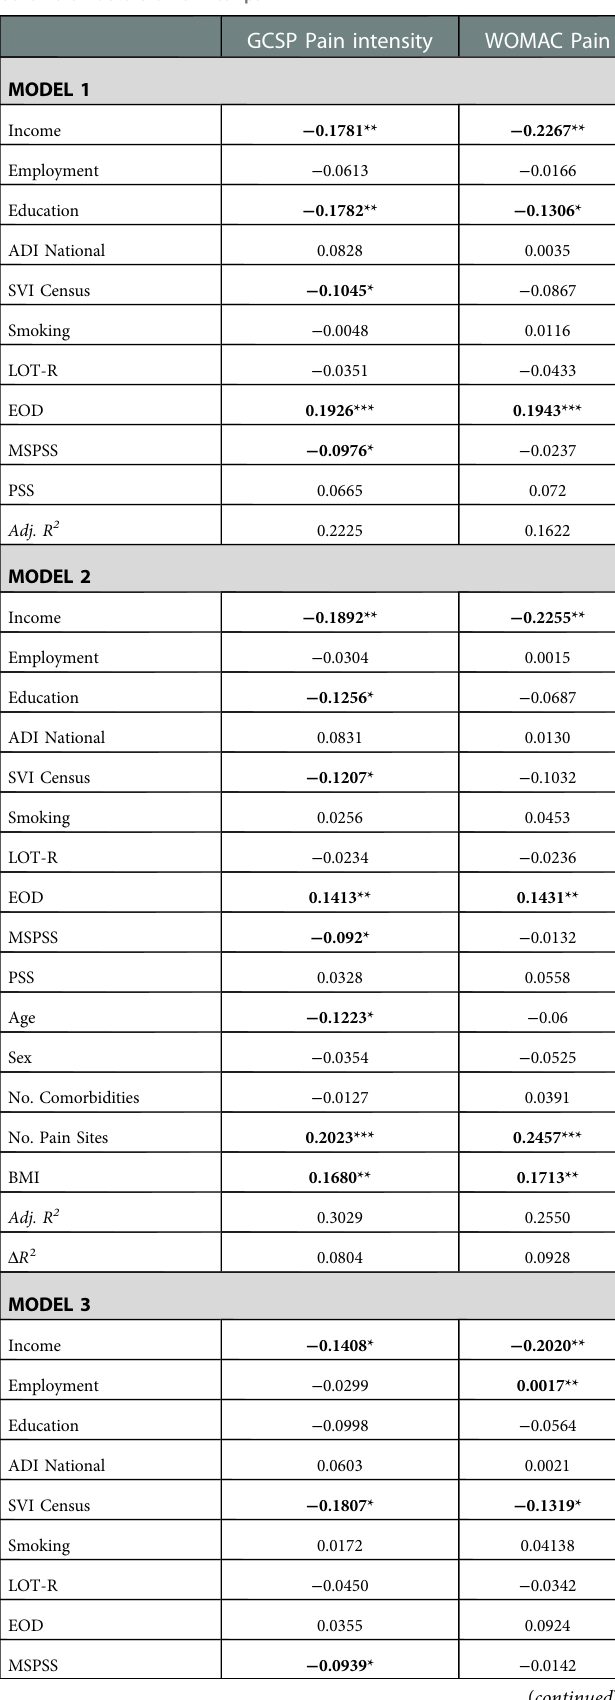
TABLE 2 Nested linear regression models assessing environmental and behavioral factors on clinical